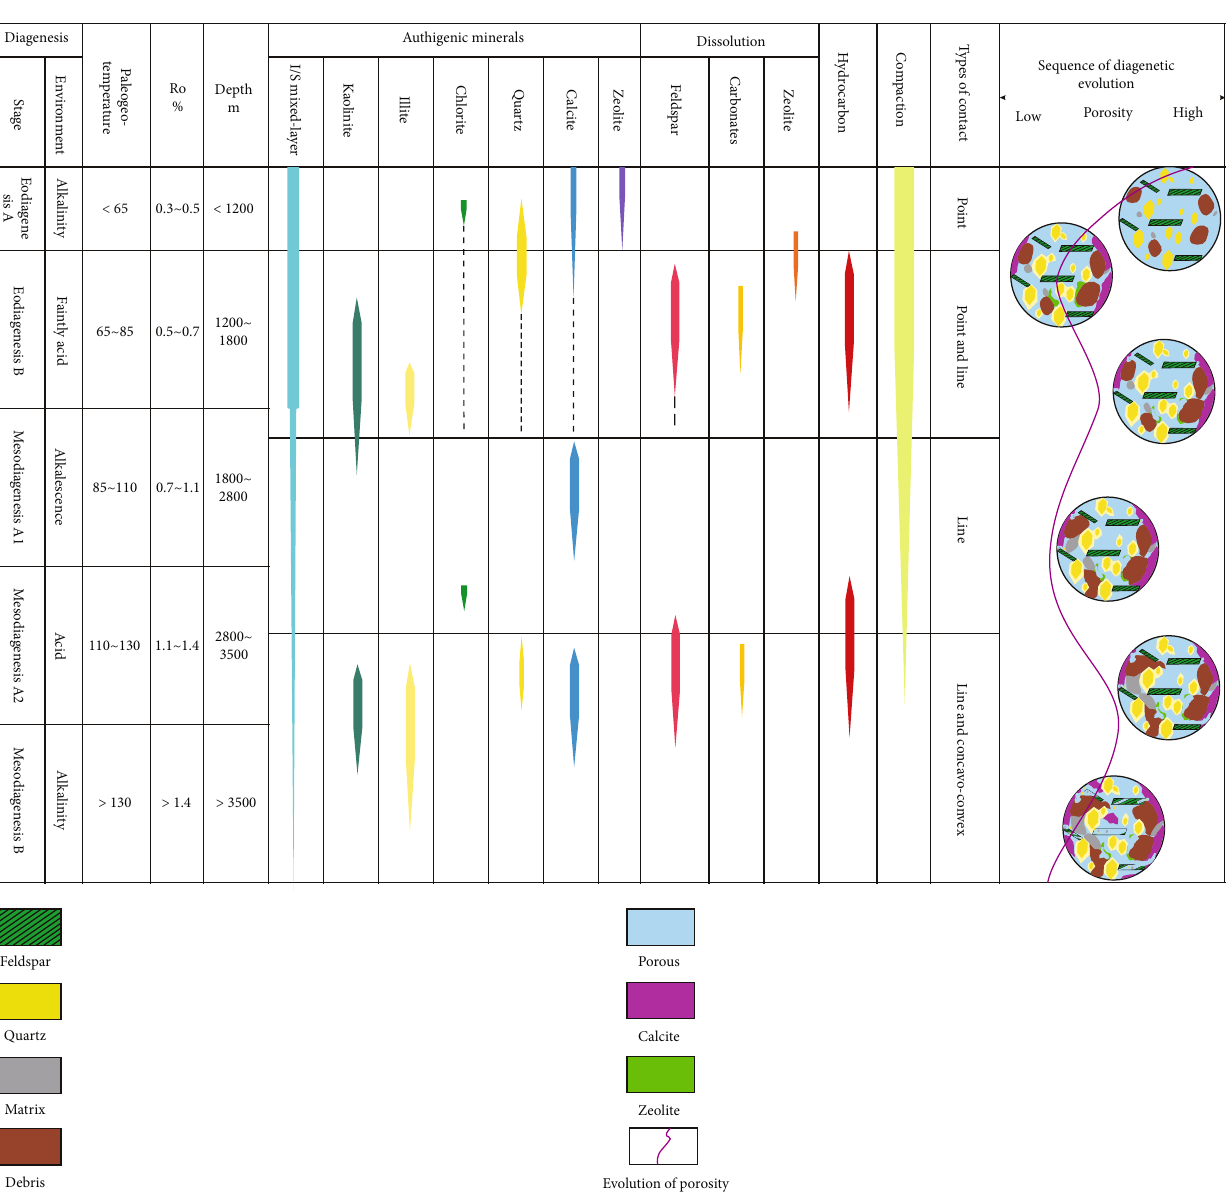
Figure 6: Synthetic diagram showing the diagenetic sequence and porosity evolution of Baikouquan formation in Mahu